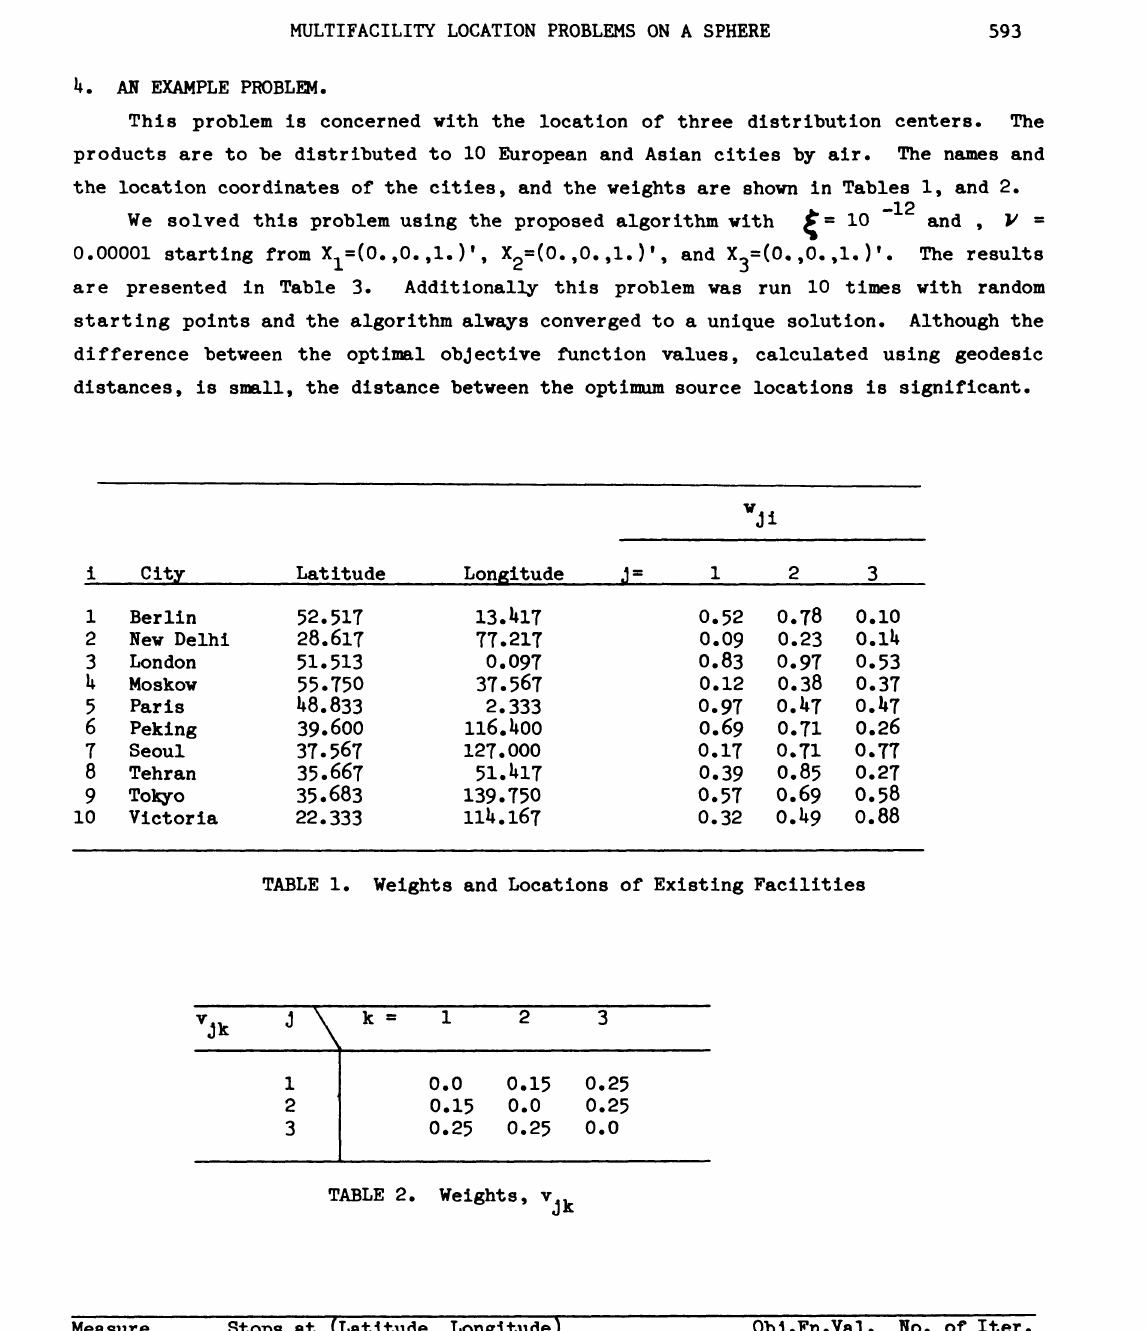
TABLE I. Weights and Locations of Existing